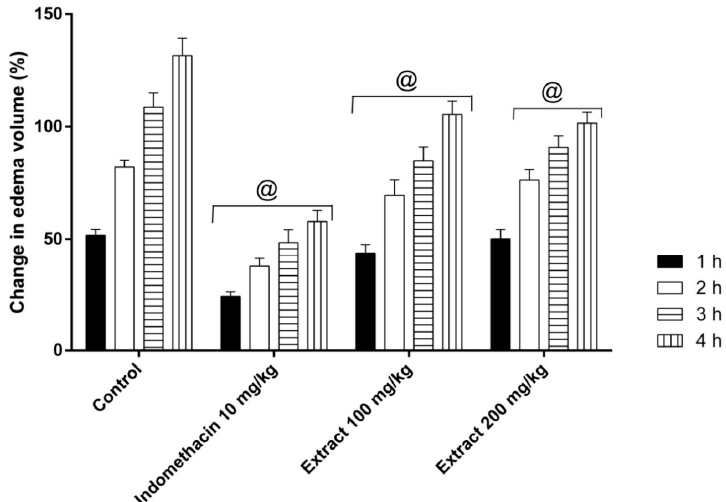
Figure 4. Anti-inflammatory protective effect of C. gilliesii leaves on carrageenan-induced inflammation in rats. The data are represented as means ± SE. @ p < 0.05 vs control group.